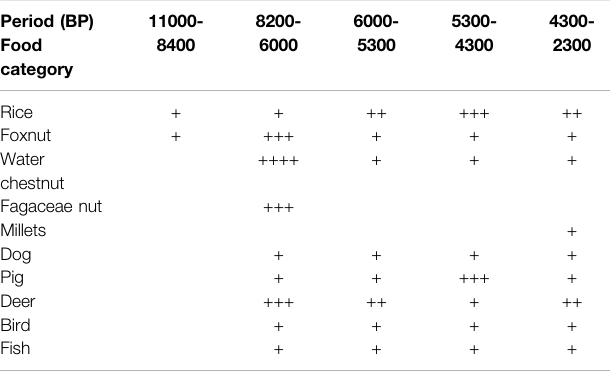
TABLE 2 | The animal and plant species mainly used in different periods (modi fi ed from Pan and Yuan,